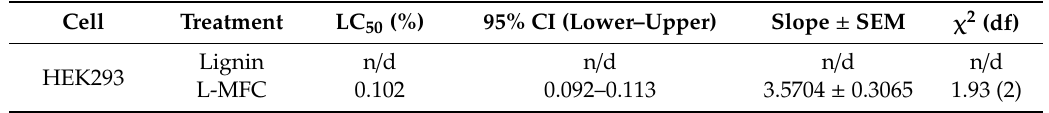
Table 3. LC 50 value of L-MFC in HEK293 cells.